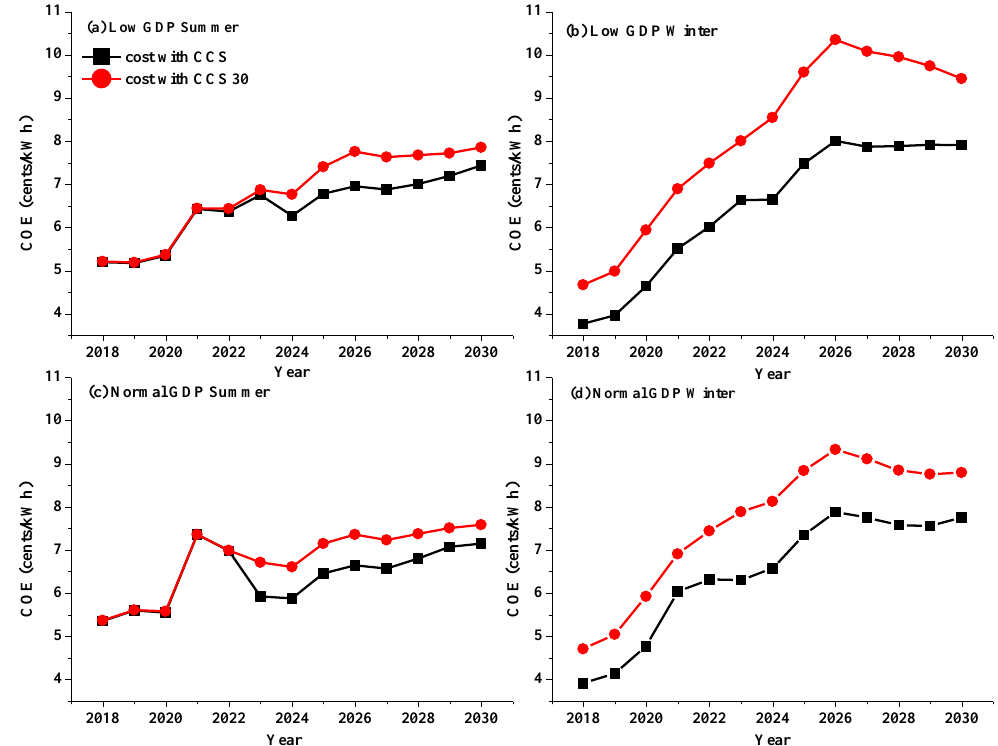
Figure 15. Cost of electricity for CCS case at 30% operational constraint on fossil fuel based power plants compared with the CCS case without such constraint.